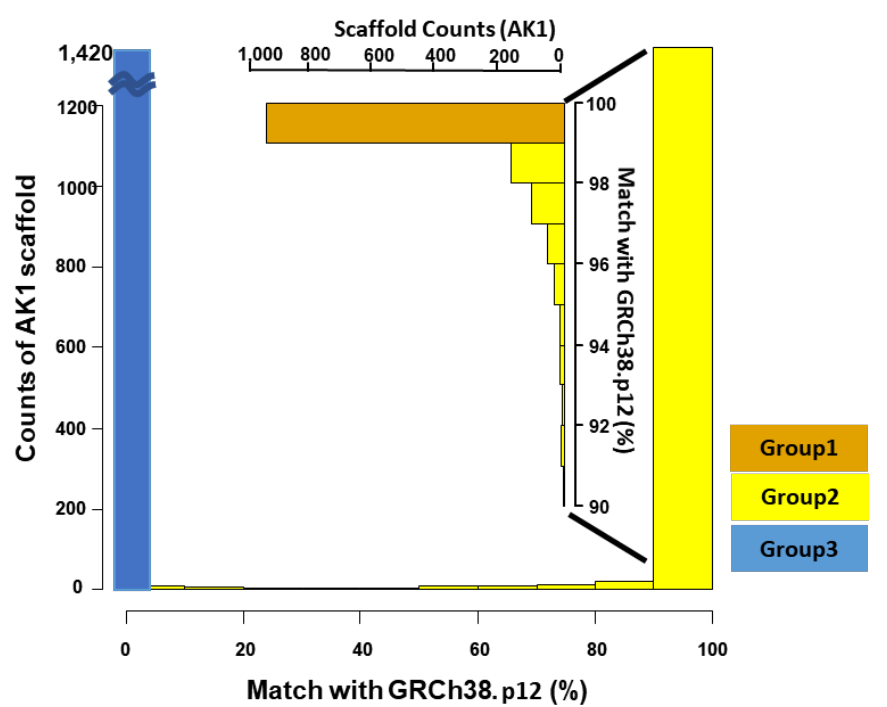
Figure 1. A systematic comparison between AK1 sca ff olds ( n = 2382) and GRCh38.p12. The degree of match divided AK1 sca ff olds into three distinct patterns of synteny by LASTZ [14]. The x axis (and vertical pop-up axis for Group 1) represents the percent of matches between AK1 sca ff old and GRCh38.p12 chromosomes, and the y axis represents the count of sca ff olds. GRCh38.p12, Genome Reference Consortium Human Build 38 patch release